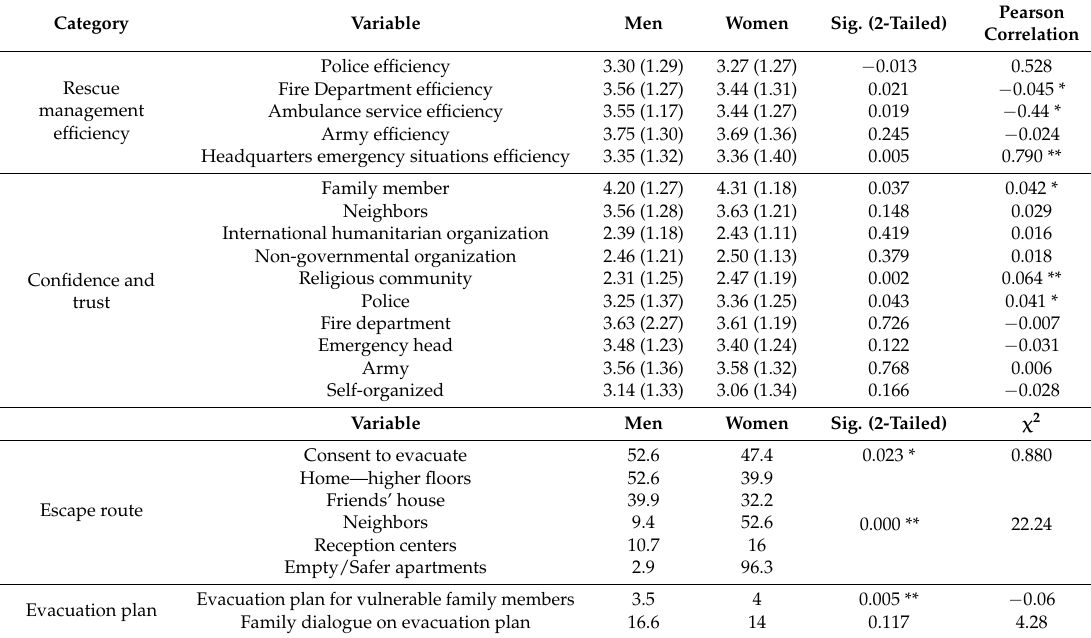
Table 8. Pearson correlation and Chi-square test results between gender and evacuation and rescue management. Likert scales means are shown, and standard deviations are presented in parenthesis for the first two set of